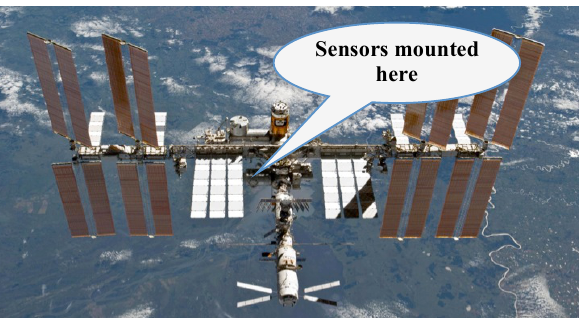
Figure 5. Location of the Second-Generation sensors on the